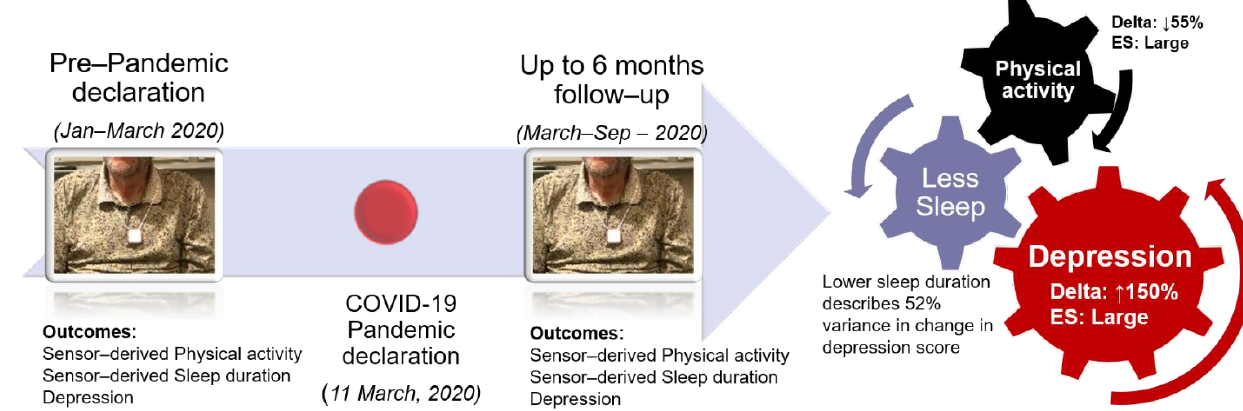
Figure 6. In this study, we followed a cohort of community-dwelling older adults (n = 10) from the pre-pandemic to up to 6 months post declaration of the COVID-19 pandemic (11 March 2020). The results suggest that, compared to pre-pandemic physical activity (daily step count) it is reduced by 55%, and depression is increased on average by 150%. Our results also suggest that lower sleep duration (time in bed during the night-time) describes 52% of the variance in change in depression score. Abbreviation: ES represents effect size.